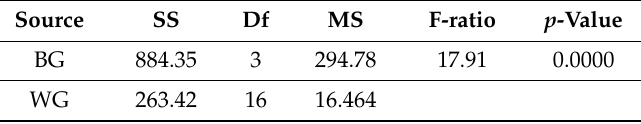
Table 4. ANOVA test for tensile strength of five